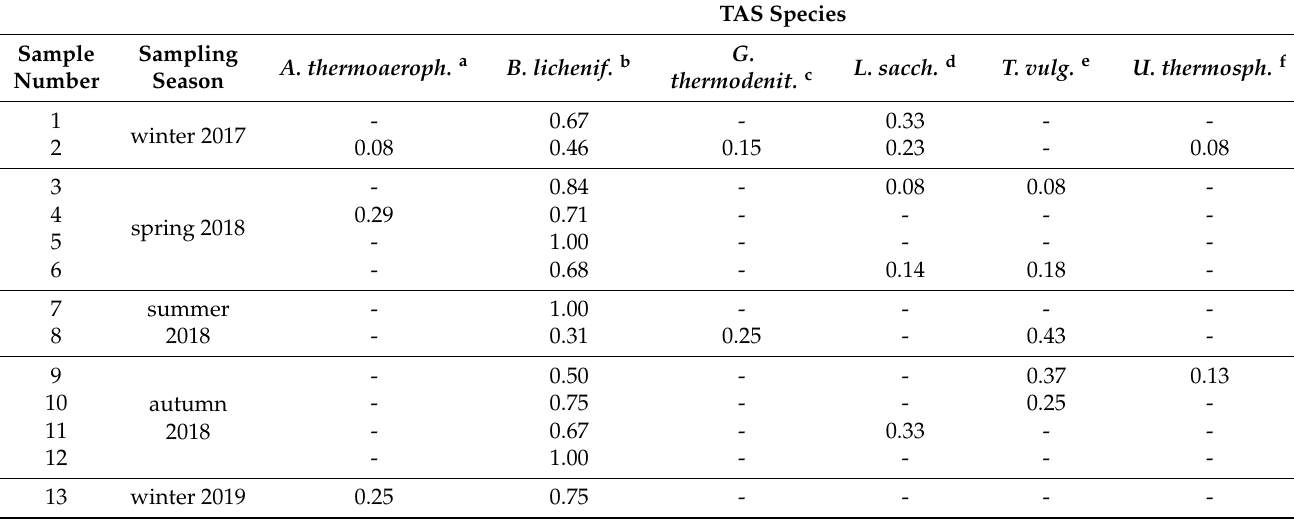
Table 3. Frequencies (%) of the identified TAS species after the cultivation of 13 different compost-bedded pack barn (CBP) bedding samples and 16S rRNA-gene